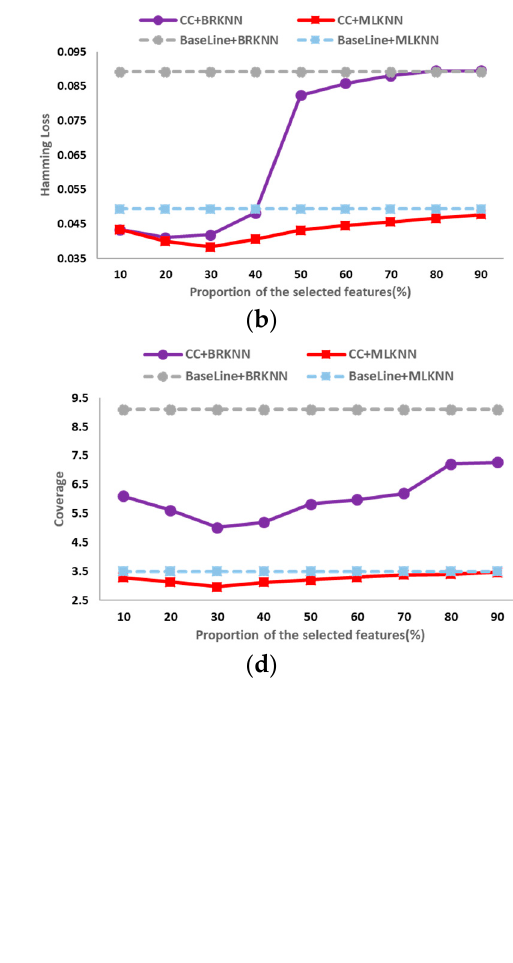
Figure 5. Experimental results on Entertainment data set. ( a ) Average Precision; ( b ) Hamming Loss; ( c ) One Error; ( d ) Coverage; ( e ) Ranking Loss.